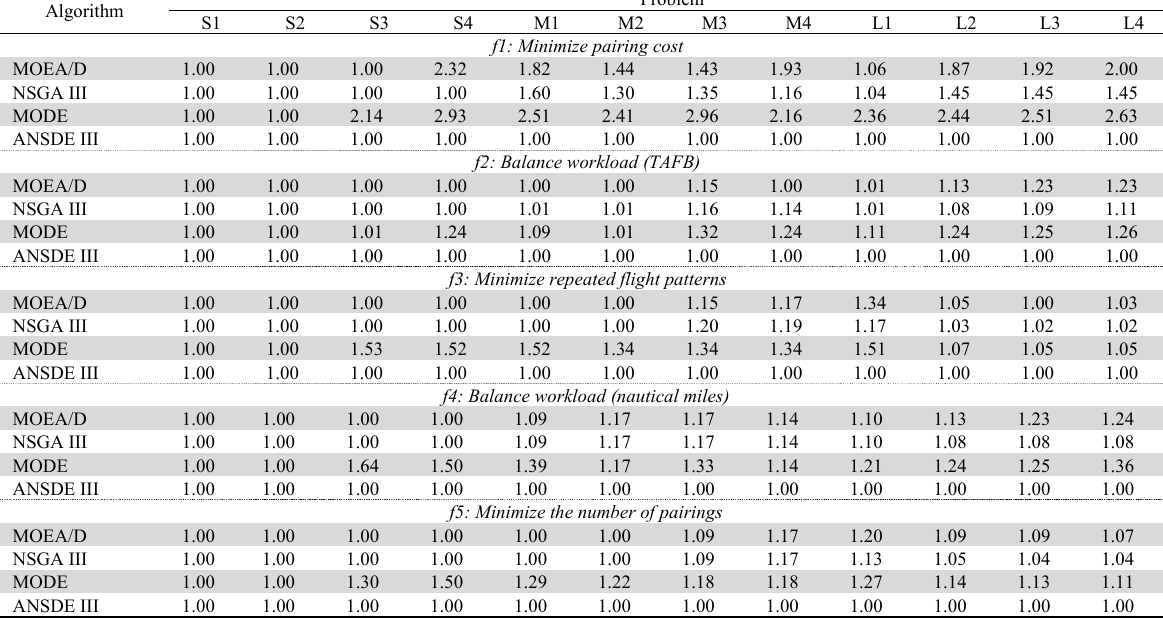
Best objectives ( 𝐵𝐹𝑀 ) found by the four different algorithms